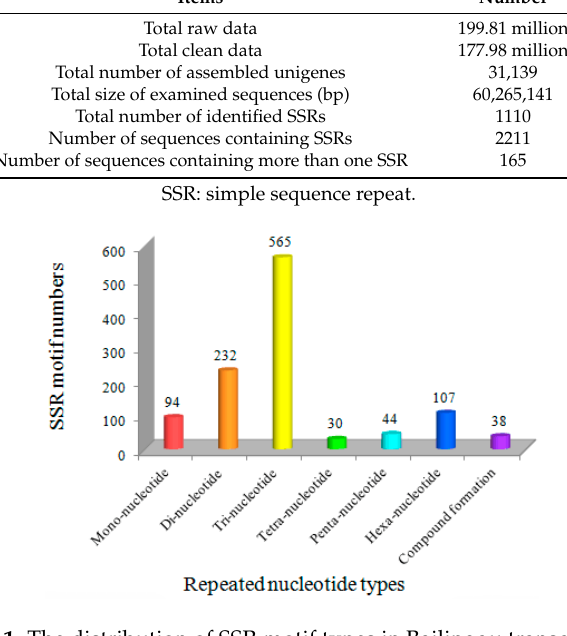
Figure 1. The distribution of SSR motif types in Bailinggu transcriptome.